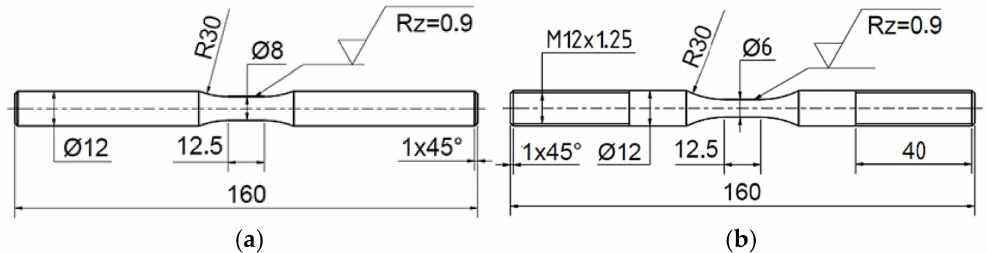
Figure 2. Specimen geometries for ( a ) low-strain-rate tensile tests and ( b ) high-strain-rate tensile tests (all dimensions in